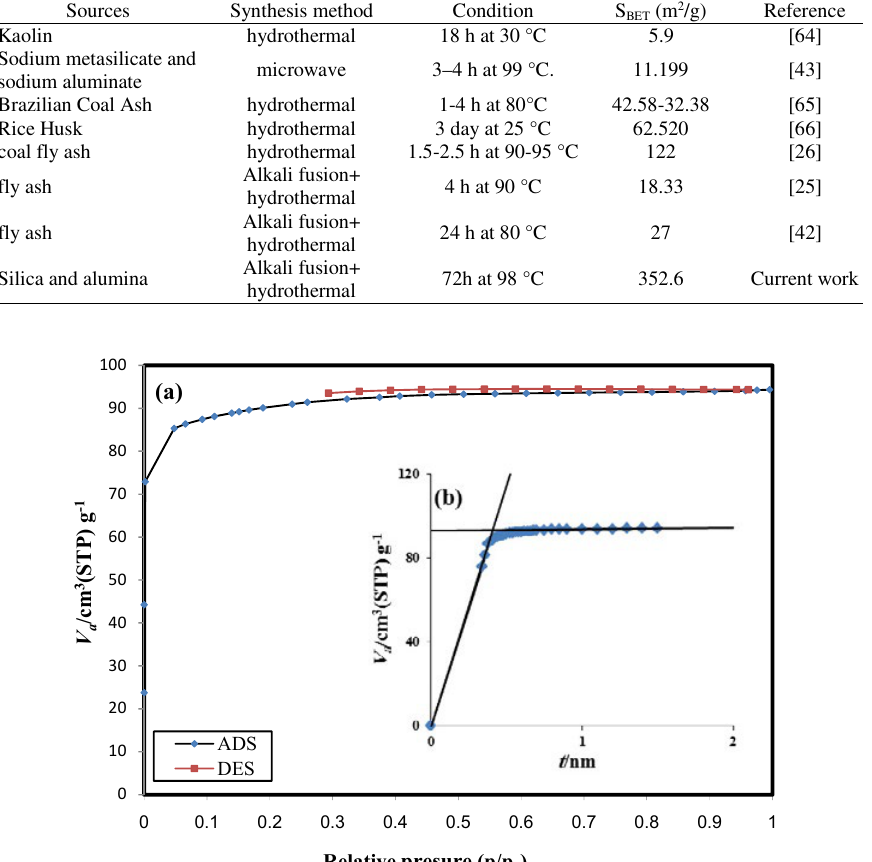
Fig. 10: N adsorption-desorption test for nano LTA zeolite. (a) Isotherm (b) 2 Fig. 10. N 2 adsorption-desorption test for nano LTA zeolite. (a) Isotherm (b) t-plot.